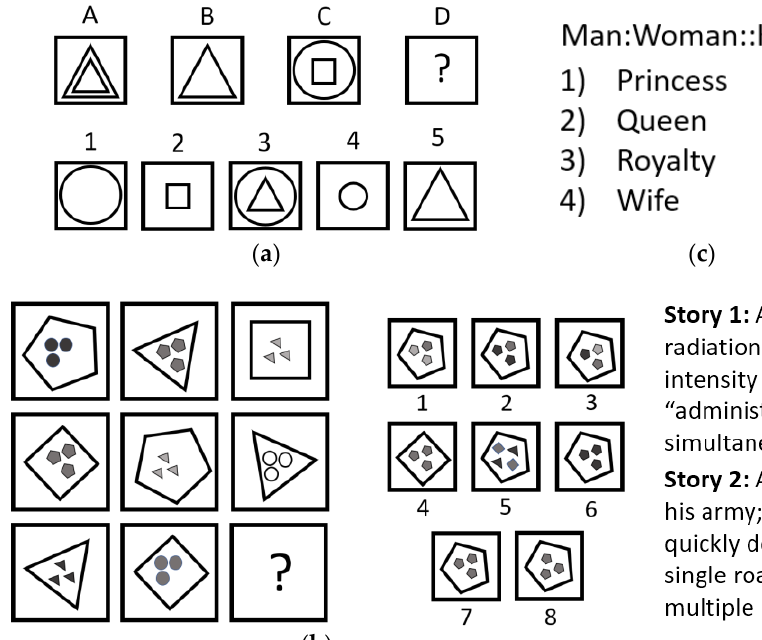
Figure 6. Example of visual and textual analogical reasoning problems; in the case of multiple choice questions (as in a,b,c), the numbers correspond to the answer choices (boxes with figures for a,b; word choices for c) presented to the viewer: ( a ) geometric A:B::C:D analogy problem utilized in Evans’ 1964 ANALOGY algorithm (adapted with permission from Ref. [56]. 1964, Evans); ( b ) geometric matrix analogy problem from the RAVEN dataset (adapted with permission from Ref. [49]. 2019, Zhang et al.); ( c ) verbal word analogy problem in the multi-choice format of A:B::C:D (reprinted with permission from Ref. [63]. 2014, Levy & Goldberg.); ( d ) verbal sentence-based analogy problem (Reprinted with permission from Ref. [64]. 2001, Eliasmith.); ( e ) verbal story-based analogy problem (Adapted with permission from Ref. [65]. 1945, Duncker & Lee).